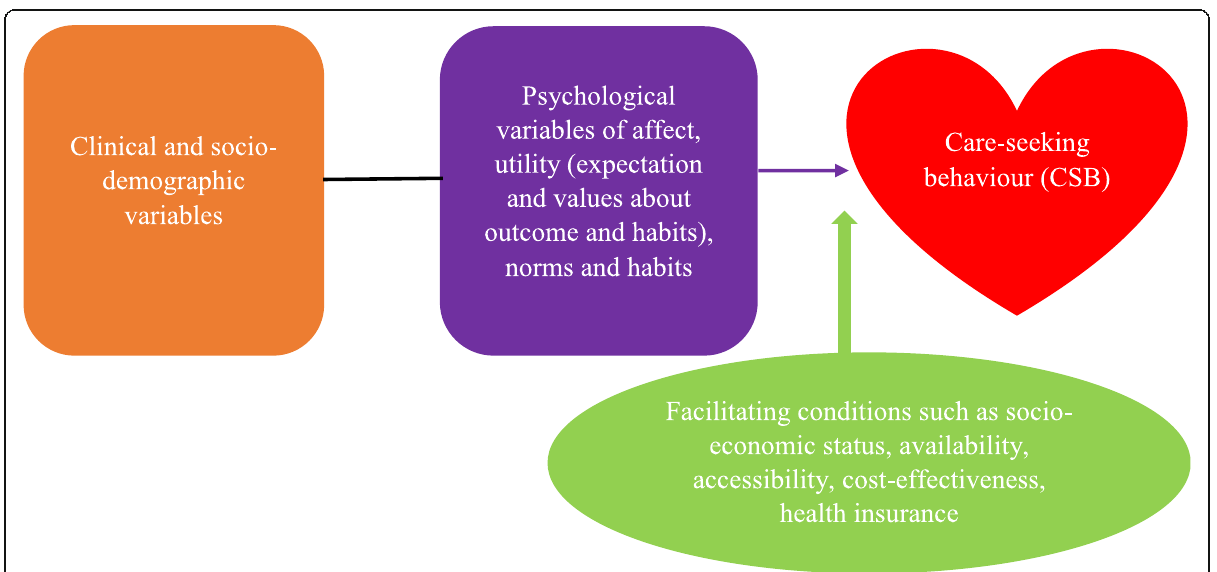
Fig. 1 Visual presentation of the CSB